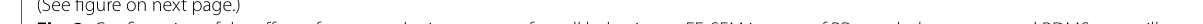
g Cell spreading area −